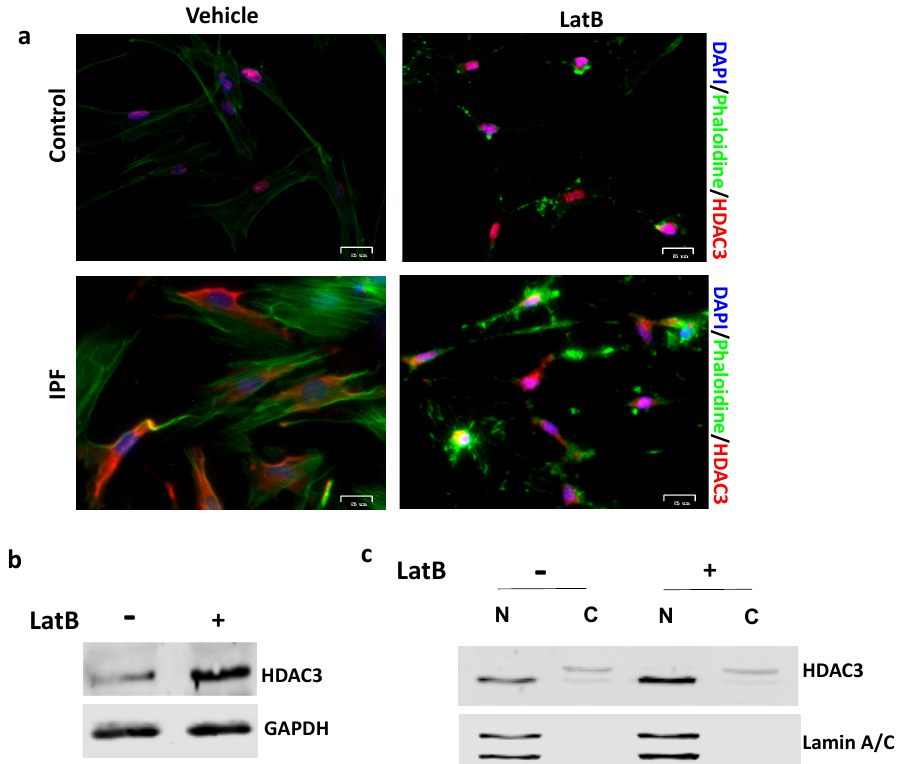
Figure 6. The actin cytoskeleton regulates the expression and localization of HDAC3. ( a ) Immunofluorescence images of HDAC3 in control and IPF fibroblasts non-treated and treated with latrunculin B (1 µ M) for 70 min, HDAC3 (red), phalloidin (green), and DAPI (blue). Representative immunoblots of HDAC3 from ( b ) the total lysate and ( c ) the nuclear and cyoplasmic extracts of fibroblasts treated or not with the actin polymerization inhibitor.